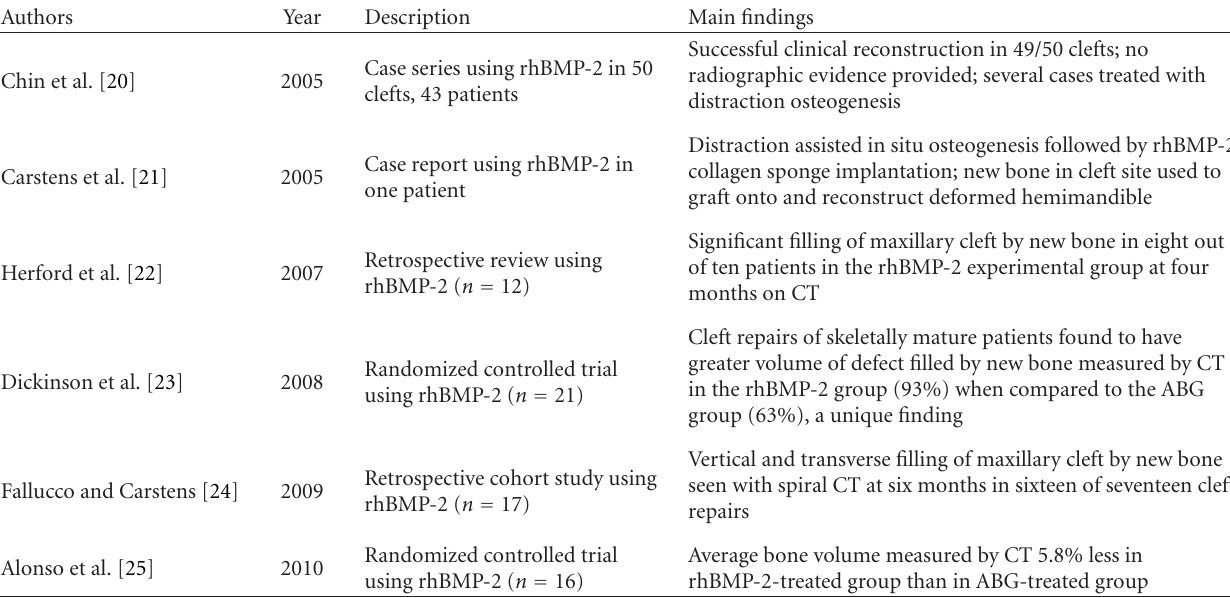
Table 1: Selected clinical studies using rhBMPs for human cleft